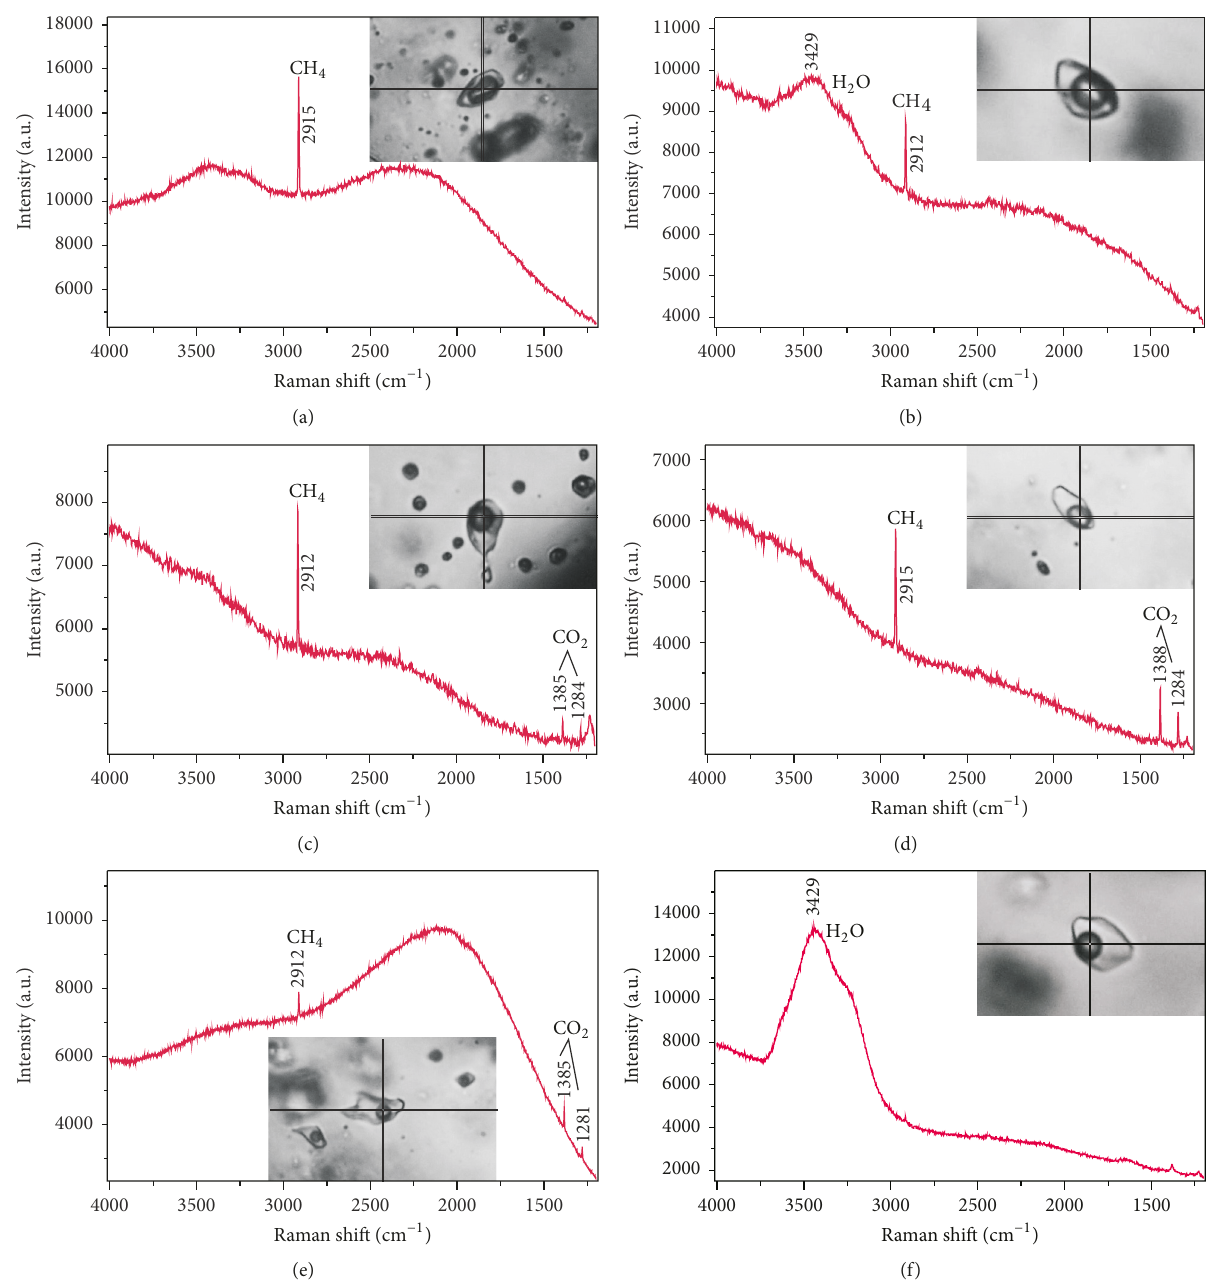
Figure 7: Laser Raman microspectrometry of primary fluid inclusions in hydrothermal quartz and fluorite of the Bairendaba Ag-Zn-Pb deposit. ((a), (b)) Type Ι inclusions in Stage 1 quartz. ((c), (d)) Type ΙΙ inclusions in Stage 2 - 1 quartz. (e) Type ΙΙ inclusions in Stage 2 - 2